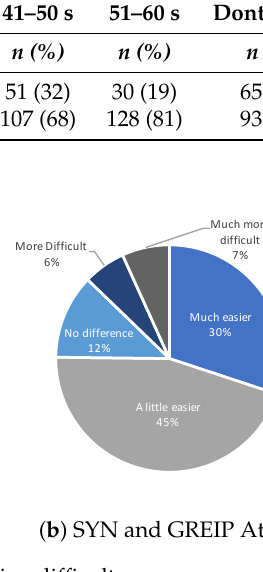
Figure 7. User perception of detection